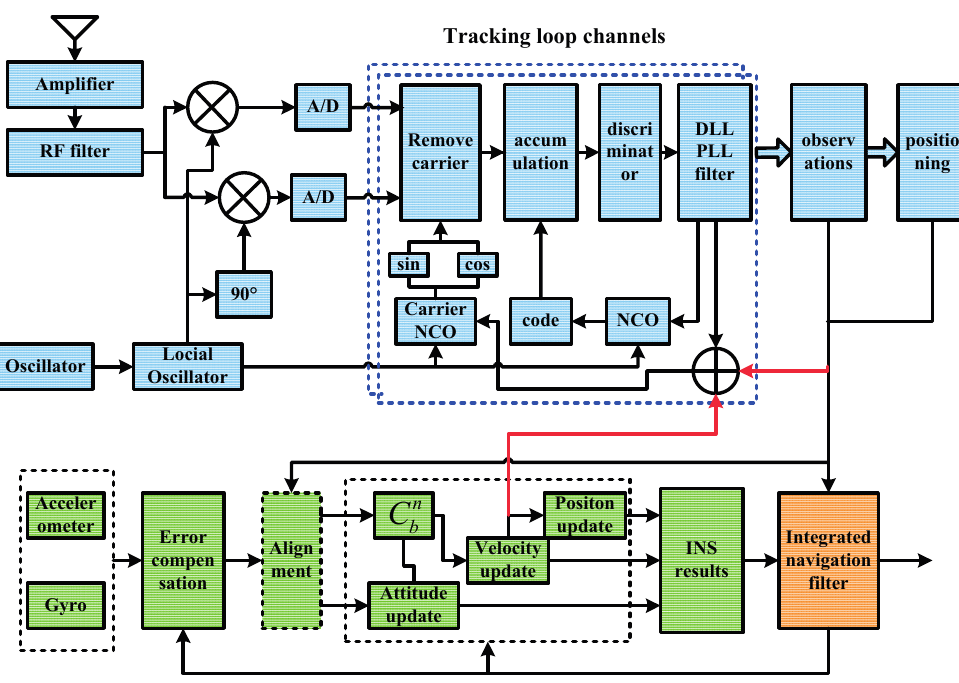
Figure 3. Detailed architecture of a scalar-based deeply-coupled system. DLL, delay lock loop.